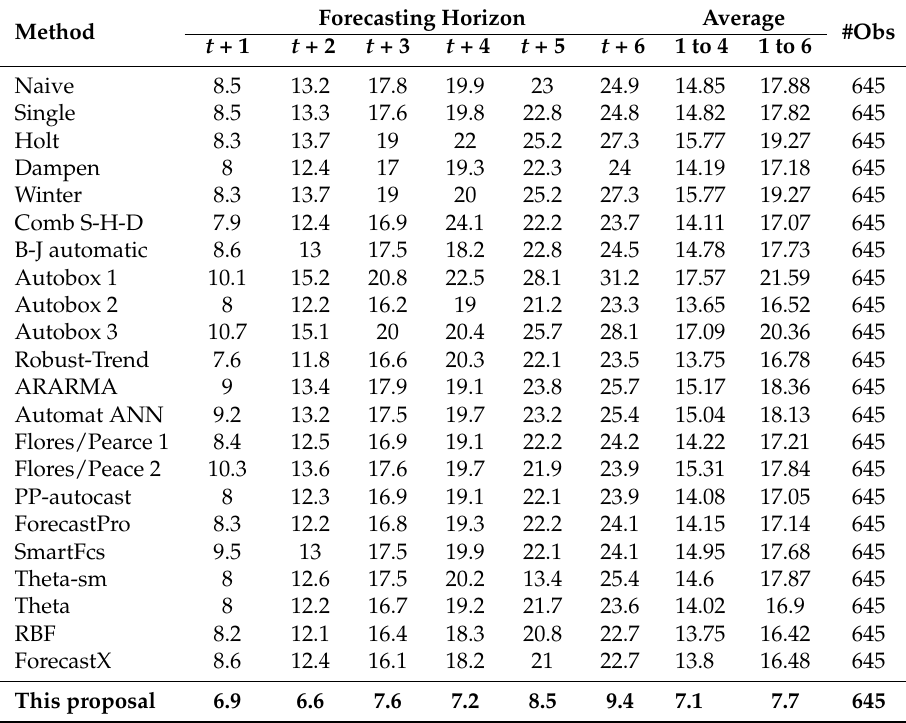
Table 5. SMAPE on M3-Competition for Yearly